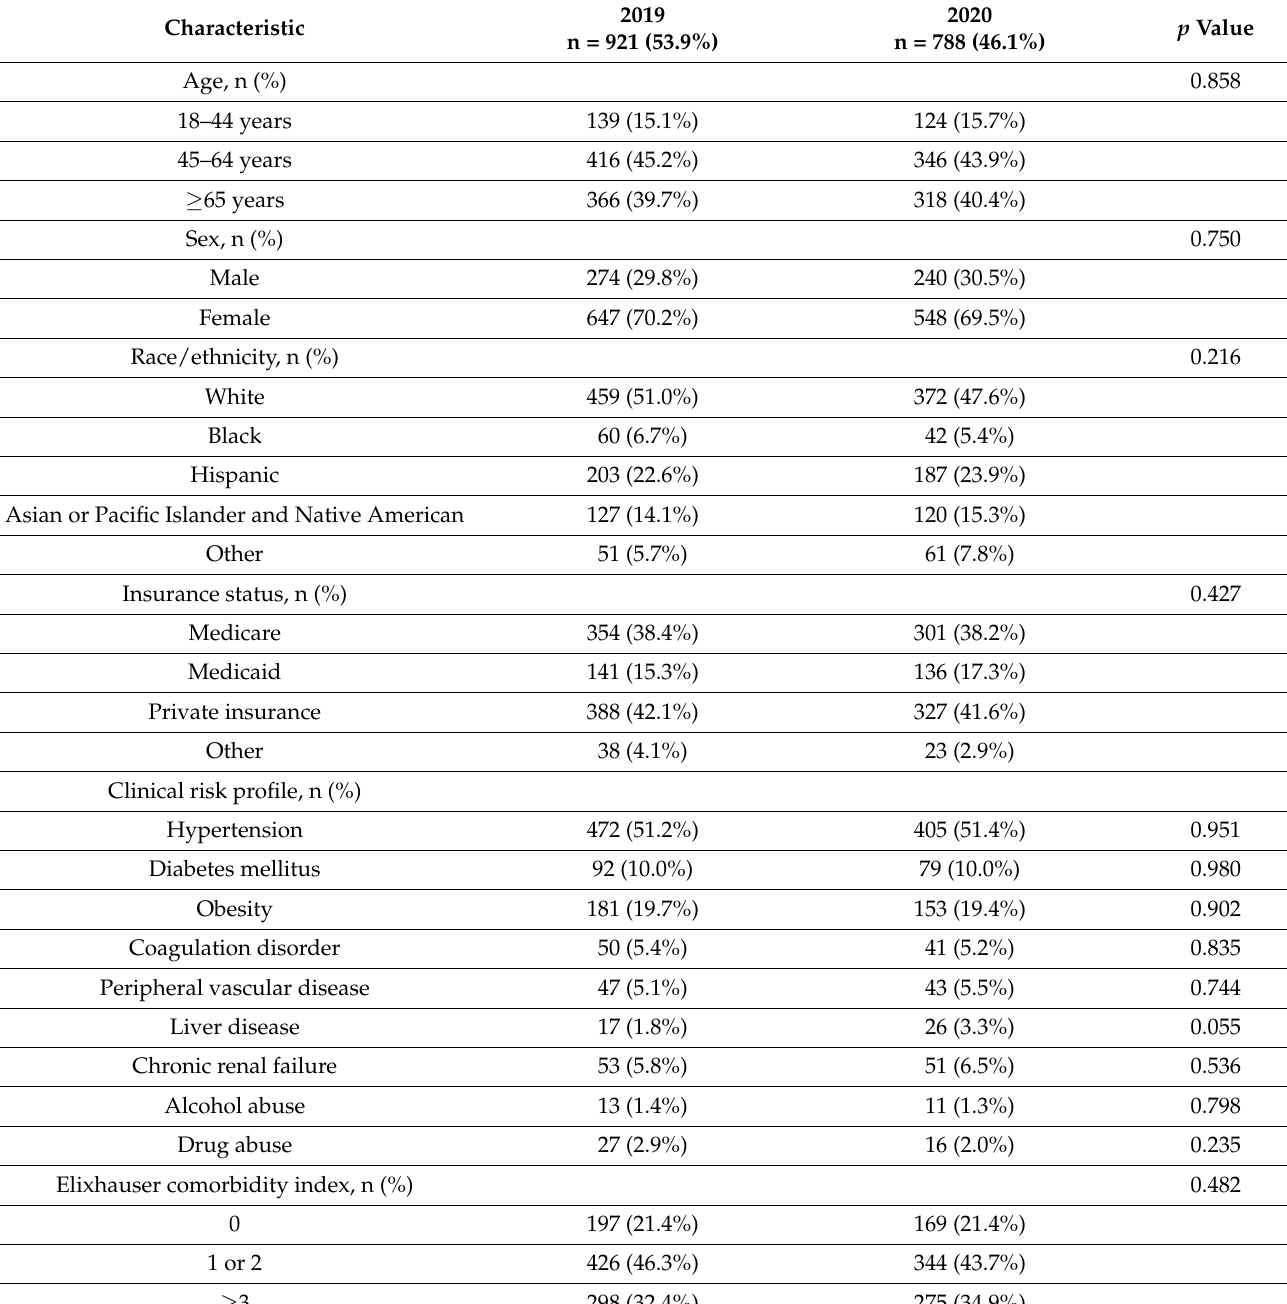
Table 1. Demographic and clinical characteristics of hospitalizations for intracranial